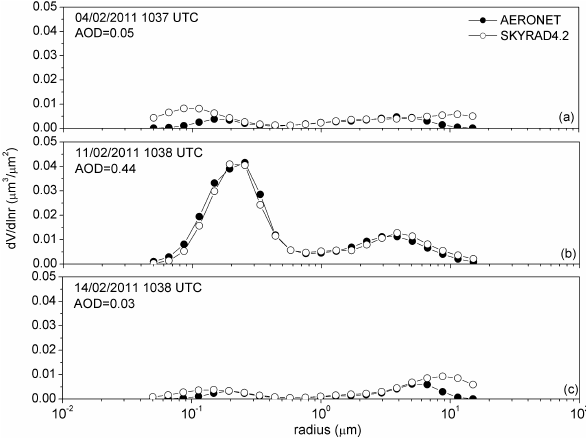
Fig. 3. Comparison between SKYRAD and AERONET distribu- tions for three representative cases of the dataset: before, during and after the pollution episode.